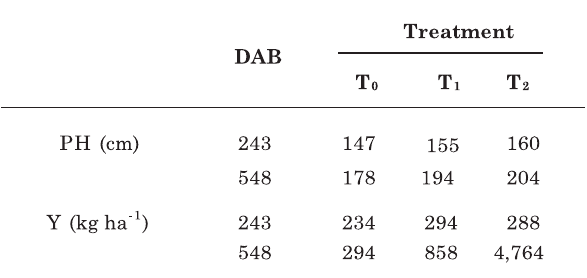
Figure 3. Rainfall (P), average air temperature (T evapotranspiration (ETc) in the experimental period. Table 1. Plant height (PH) and coffee bean dry matter yield (Y) for treatments T harvest times. DAB = Days after (Sept